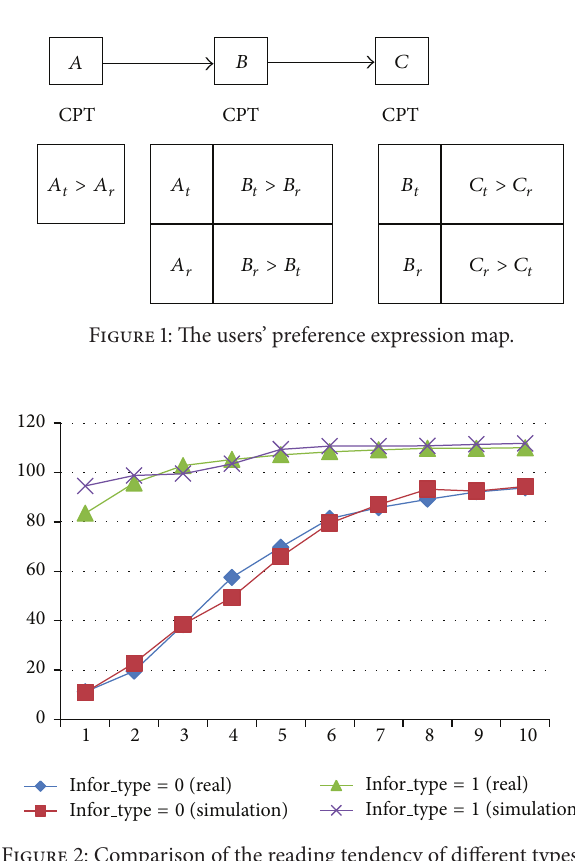
Figure 2: Comparison of the reading tendency of different types of knowledge.